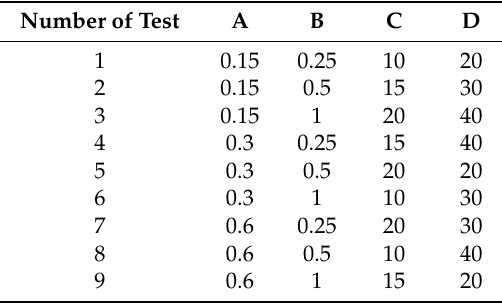
Table 10. Taguchi L 9 (3 4 ) experimental plan.